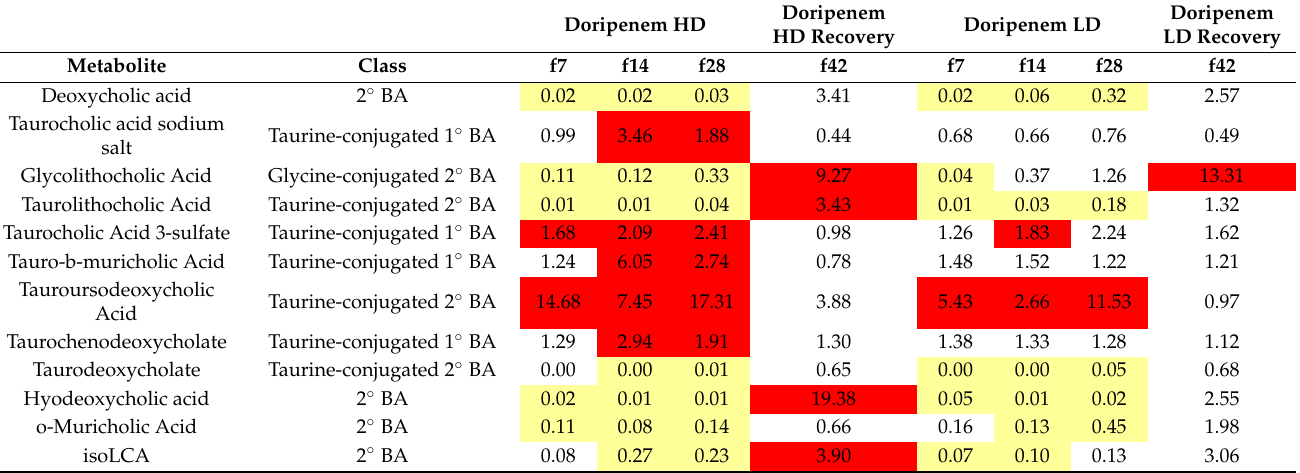
Table 11. Doripenem-induced plasma BA fold changes in female (f) Wistar rats (N = 5 per group) dosed with 100 (LD) and 1000 (HD) mg/kg bw/day observed on days 7, 14, and 28 (f7, f14, and f28) and on day 42 (f42) for the doripenem-recovery group. Statistically significant changes (Welch t -test; p -value < 0.05) are shown where red boxes mean a significant increase, yellow boxes mean a significant decrease, and white boxes indicate an insignificant change in the respective plasma BAs compared to control